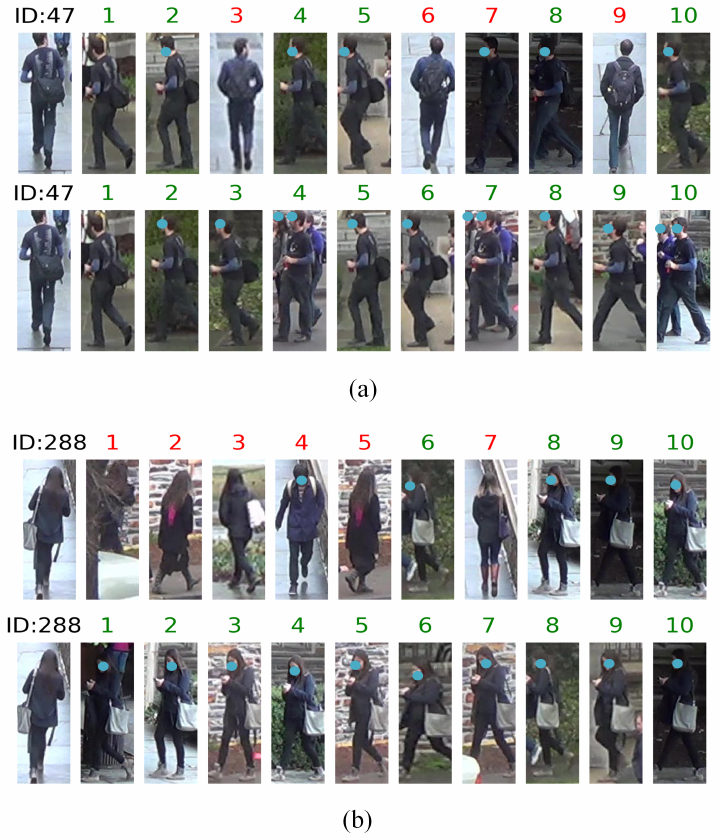
Figure 12. Comparison of visualization results of the two networks on DukeMTMC-reID. The first line is the visualization result of the baseline (without local branch, non-local, IBN, and attribute), and the second line is the result of the proposed method. We select two images with different IDs from the query. ( a ) Rank result of ID 47; ( b ) Rank result of ID